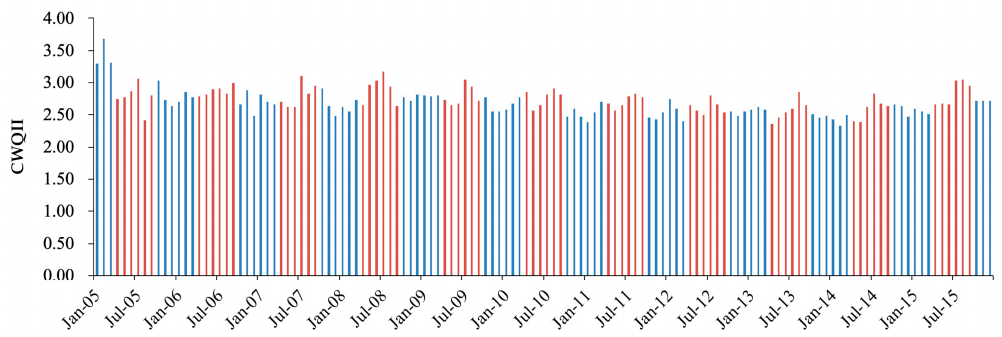
Figure 5. Temporal variation of CWQII in Xuzhou section from 2005 to 2015. The wet seasons (from April to September) were marked in red, and the dry seasons (from October to March in next year) were marked in blue.